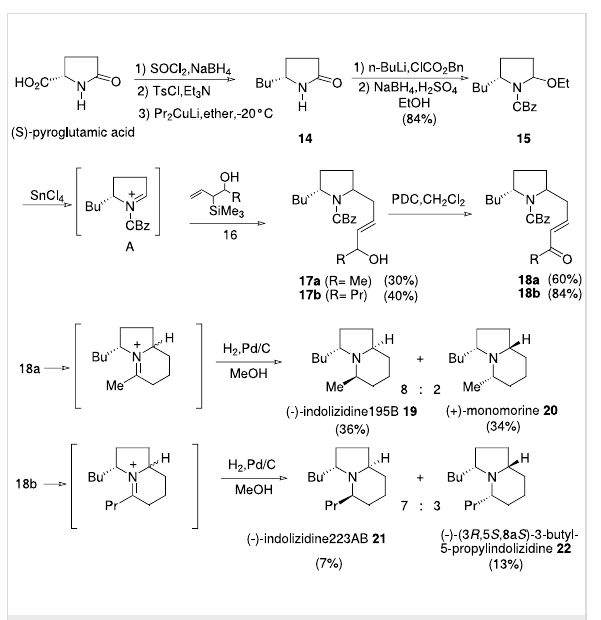
Scheme 4: Synthesis of 3,5-disubstituted indolizidines from L -pyro- glutamic